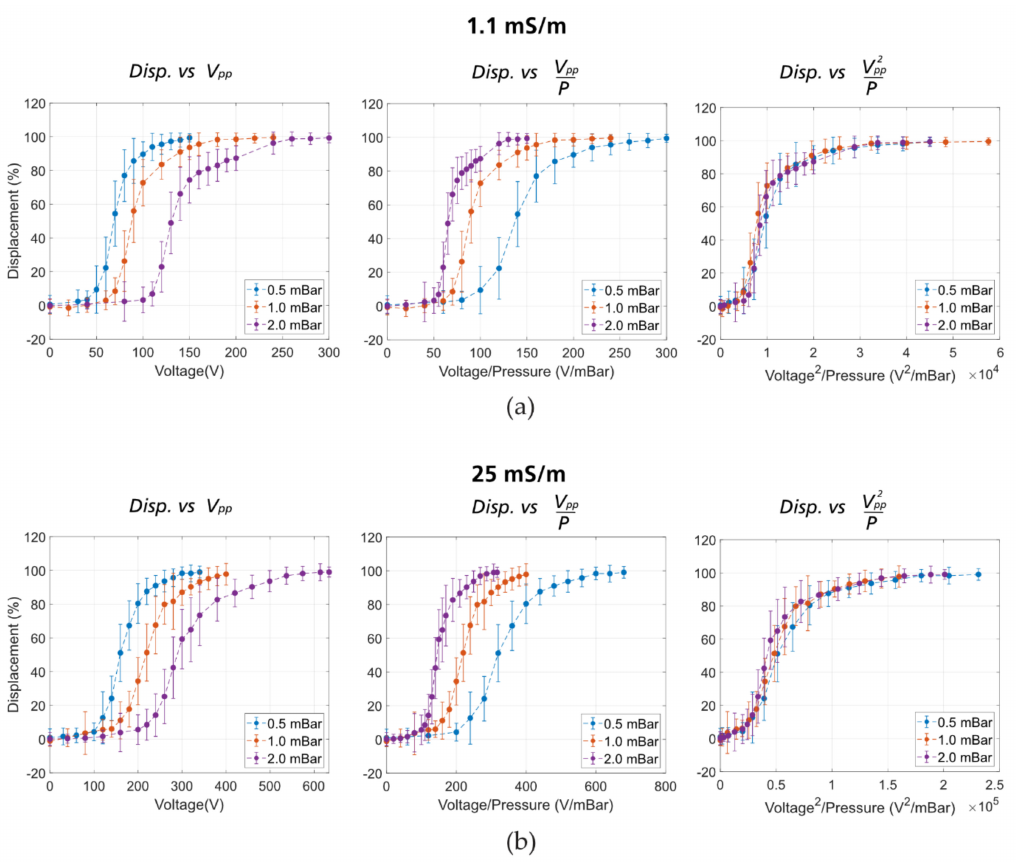
Figure 10. Displacement of 4.3 µ m beads as a function of voltage, voltage / pressure, or voltage 2 / pressure. ( a ) At medium conductivity of 1.1 mS / m. ( b ) At medium conductivity of 25 mS /